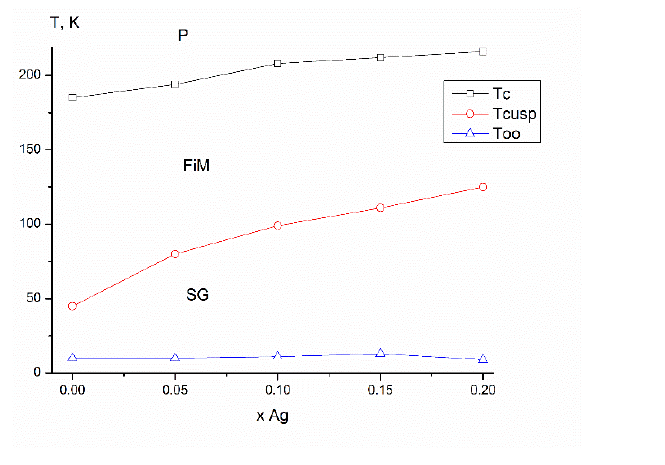
the Table 1. The diagram shows the following regions: paramagnetic, ferrimagnetic, re- current spin glass region, and region associated with orbital ordering.